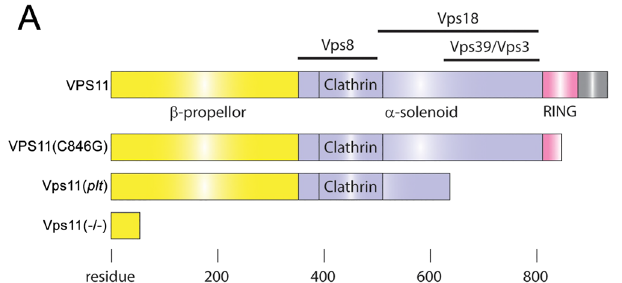
Figure 1. Schematic representation comparing the lengths and interaction domains of human VPS11 and VPS11(C846G) with zebrafish Vps11(plt) and Vps11(−/−). ( A ) Top: Schematic representation of full- length human VPS11 protein, showing multiple highly-conserved protein domains. Lines above show the putative interactive domains with other Vps effectors based largely on work done in yeast. Below: Schematic representations of human VPS11(C846G), zebrafish Vps11(plt), and zebrafish Vps11(−/−), resulting in presumptively shorter truncated protein products. Note that zebrafish and human sequences do not show 100% nucleic acid identity, but do show conserved protein